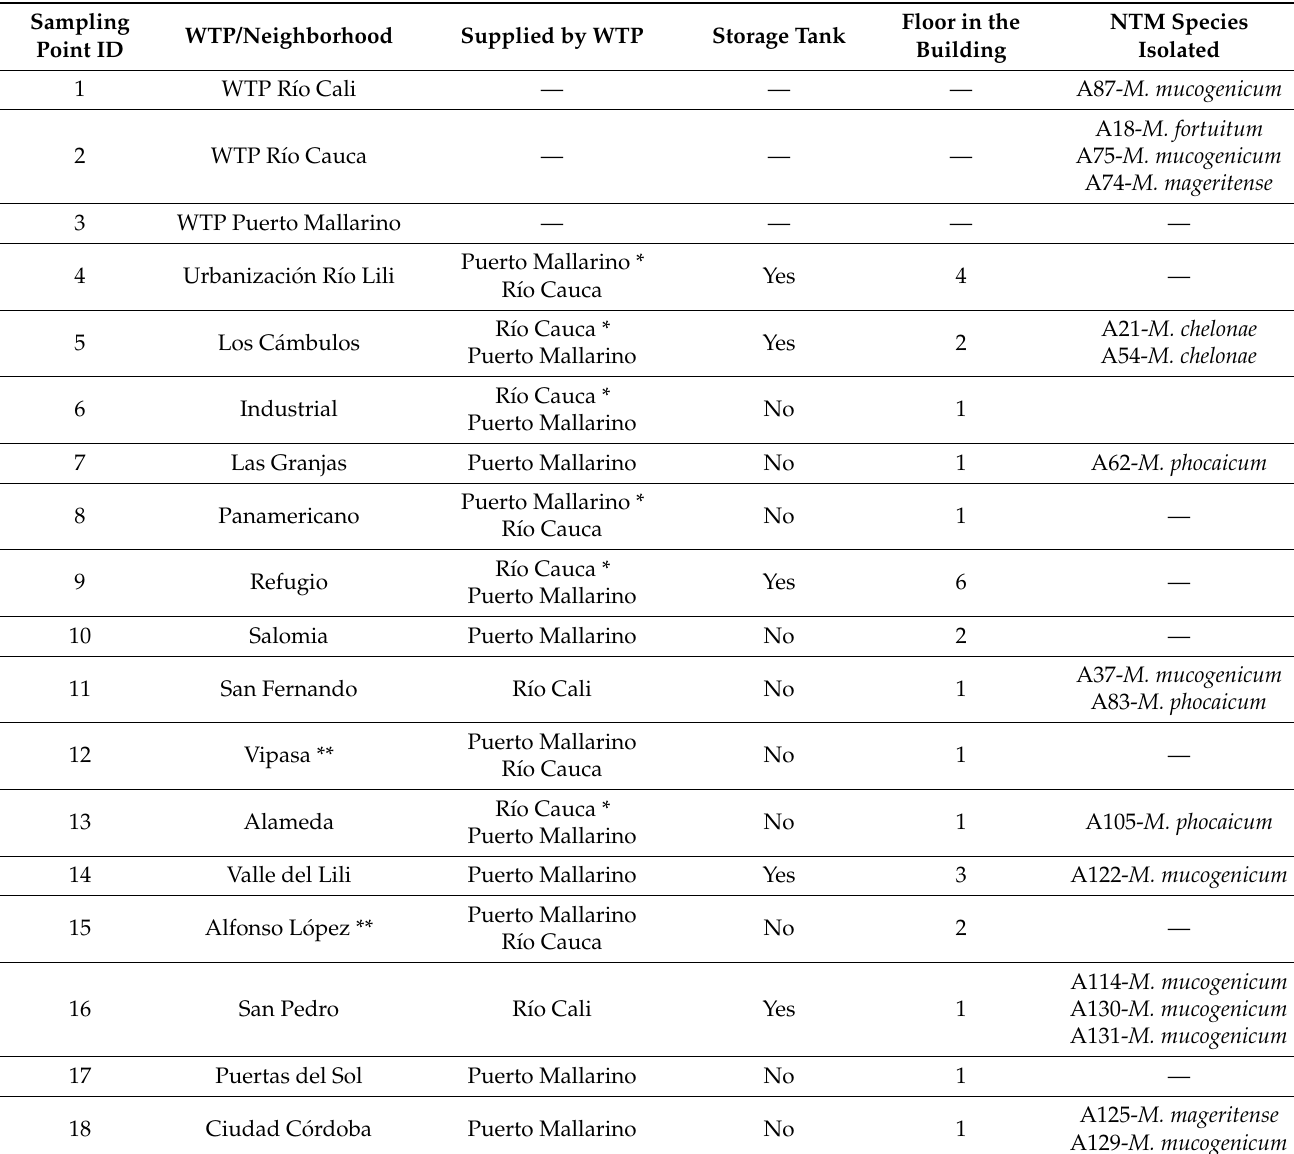
Table 1. Sampling points in the study